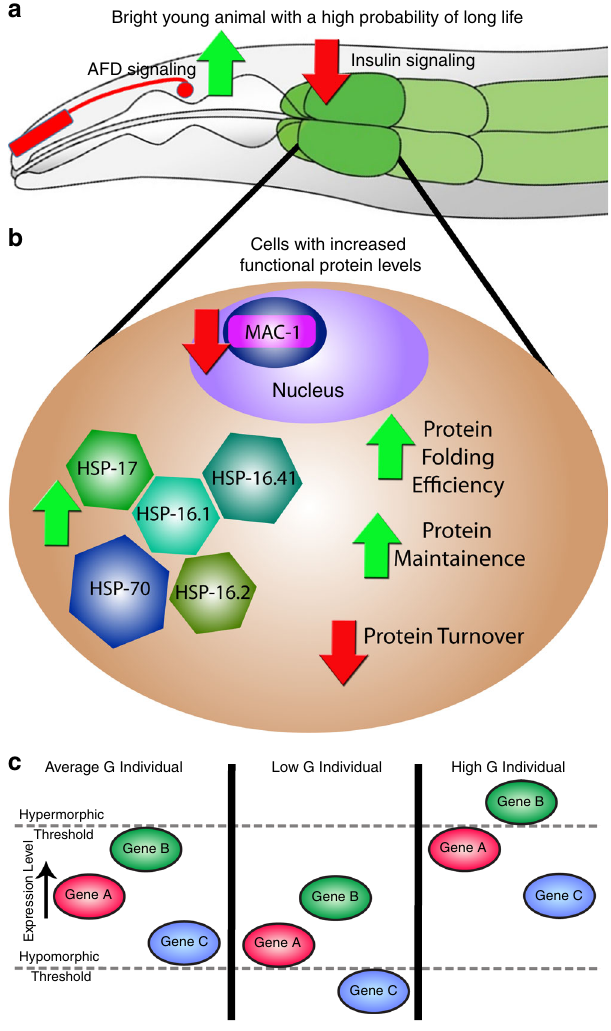
Fig. 5 Working model. a Genetic experiments from Mendenhall et al. show that interindividual variation in the hsp-16.2 reporter gene arises from differences in insulin signaling and depolarization of the AFD neuron pair 14 . Thus, animals with low insulin signaling and high neuronal depolarization would have the highest expression of the hsp-16.2 lifespan/penetrance biomarker and have the longest lifespans, highest penetrance of hypermorphic phenotypes and lowest penetrance of hypomorphic phenotypes. b Diagram of the molecular and physiological differences in cells that underlie global differences in protein dosage. Solid arrows are directly supported by experiments in C. elegans using reporter genes (here in Figs. 3, 4, and Supplementary Fig. 12) and microarrays (previously 27 ). c Three panels showing consequences of different states of protein expression capacity ( G ). Left panel shows an individual with average G and wild-type phenotypes. Middle panel shows an individual with low G and penetrance of a hypormorphic phenotype for the allele of Gene C. Right panel shows an individual with high G and penetrance of a hypermorphic phenotype for the allele of Gene